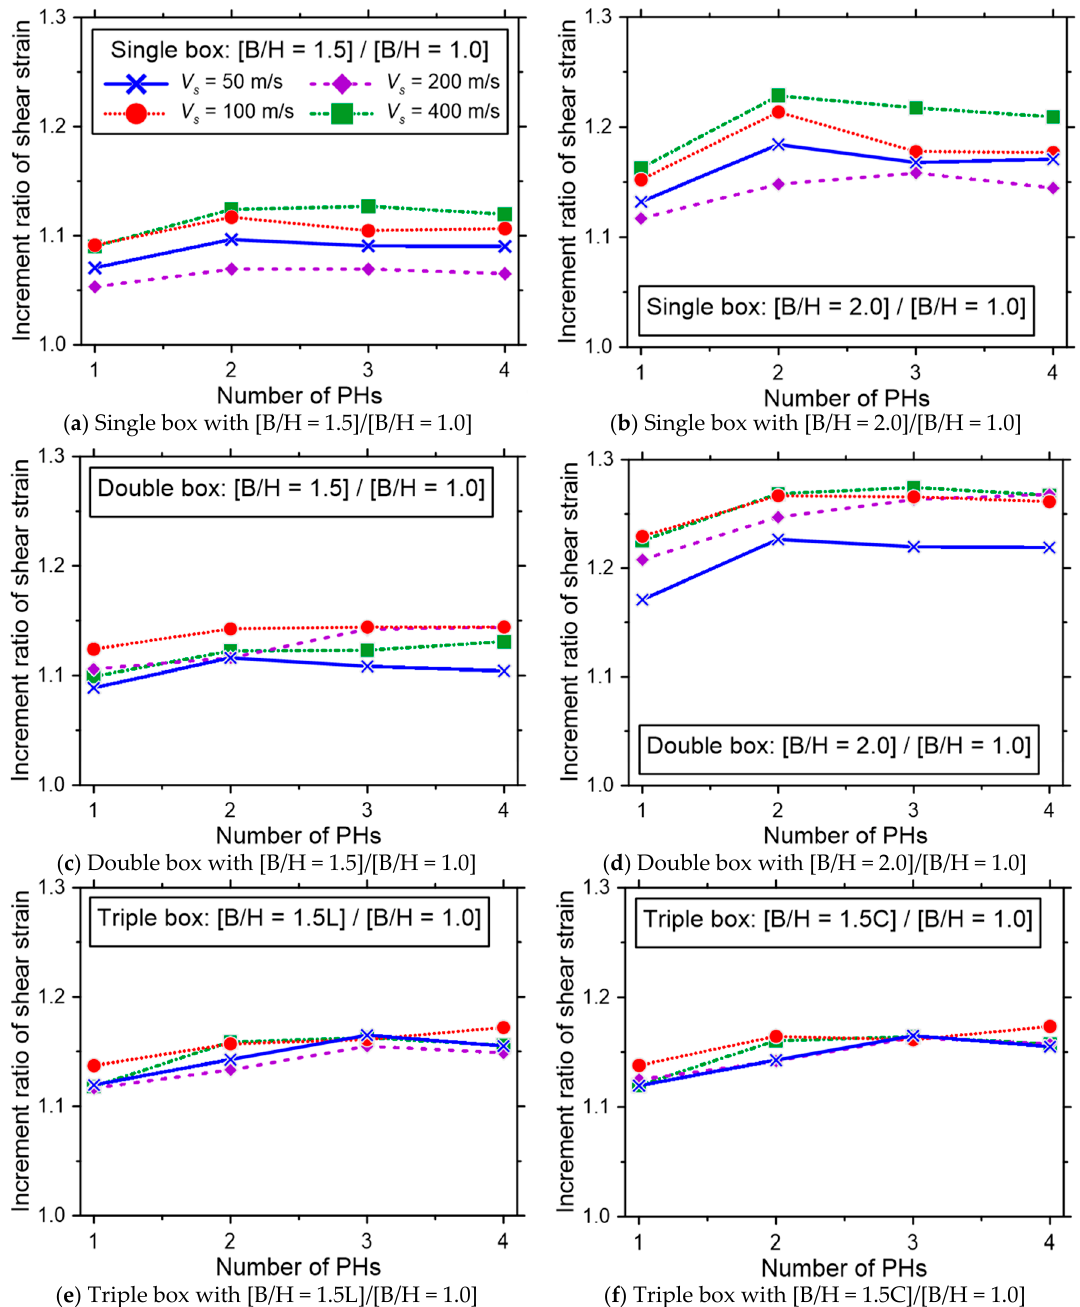
Figure 9. Increment ratio of DI with B/H vs. number of plastic hinges (PHs) of box tunnels for various shear wave velocities ( V s ) values.